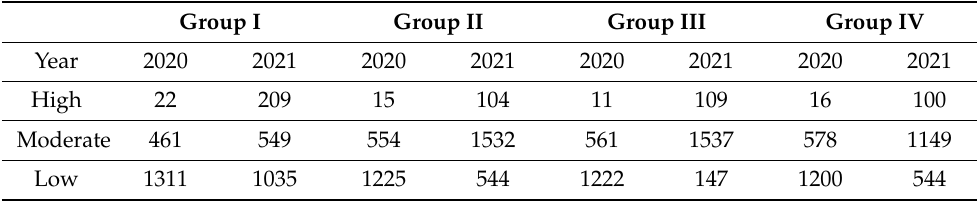
Table 10. Distribution of municipalities for the vulnerable classes for groups observed